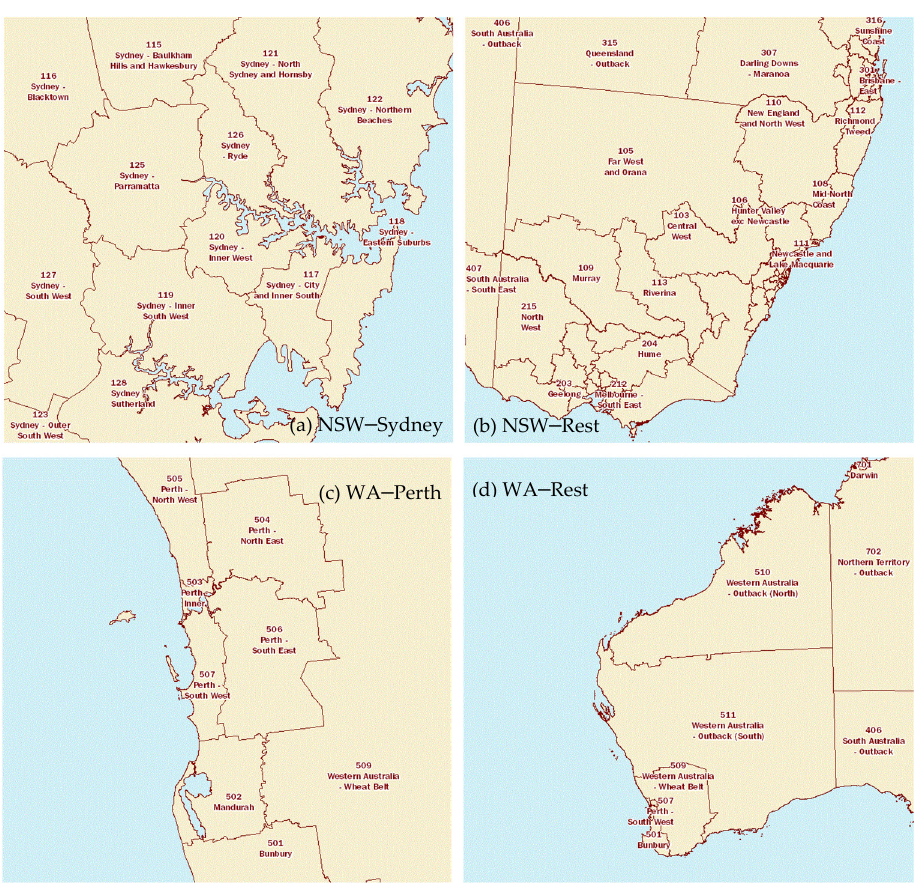
Figure 2. The map of significant areas in ( a ) NSW–Sydney, ( b ) NSW–Rest, ( c ) WA–Perth, and ( d ) WA–Rest. (Australian Bureau of Statistics 2016).